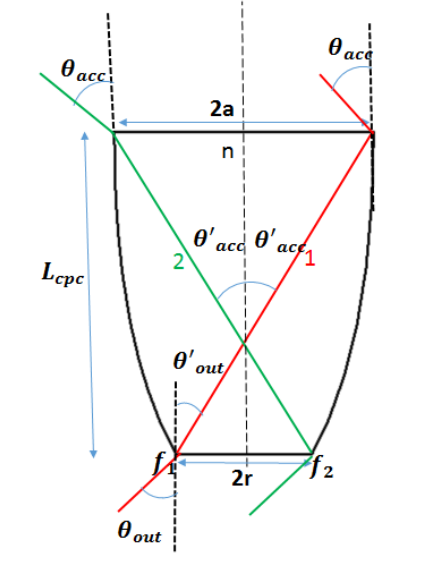
Figure 19. Compound parabolic concentrator view with the main parameters to be considered for its